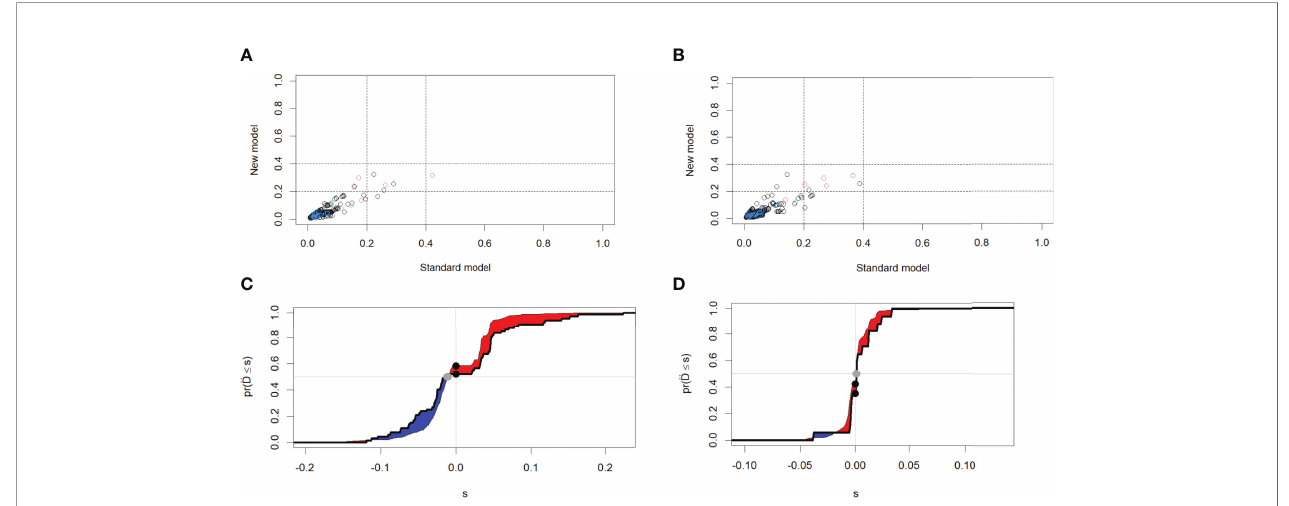
FIGURE 3 | NRI and IDI between ① model 3 and model 2a ② model 3 and model 2b. (A) NRI for ① (B) NRI for ② (C) IDI for ① (D) IDI for ② NRI, Net Reclassi fi cation; IDI, Integrated Discrimination